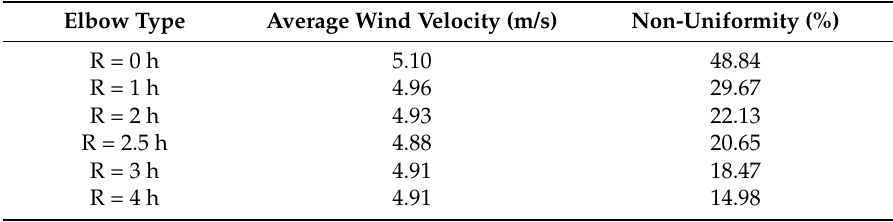
Table 3. Wind velocity distribution and non-uniformity.